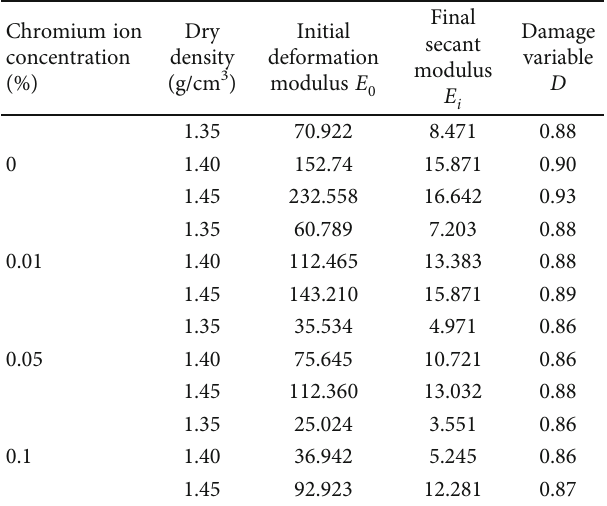
Table 10: Final damage parameter table of chromium-polluted red clay at 300 kPa con fi ning pressure under di ff erent dry densities. Chromium ion